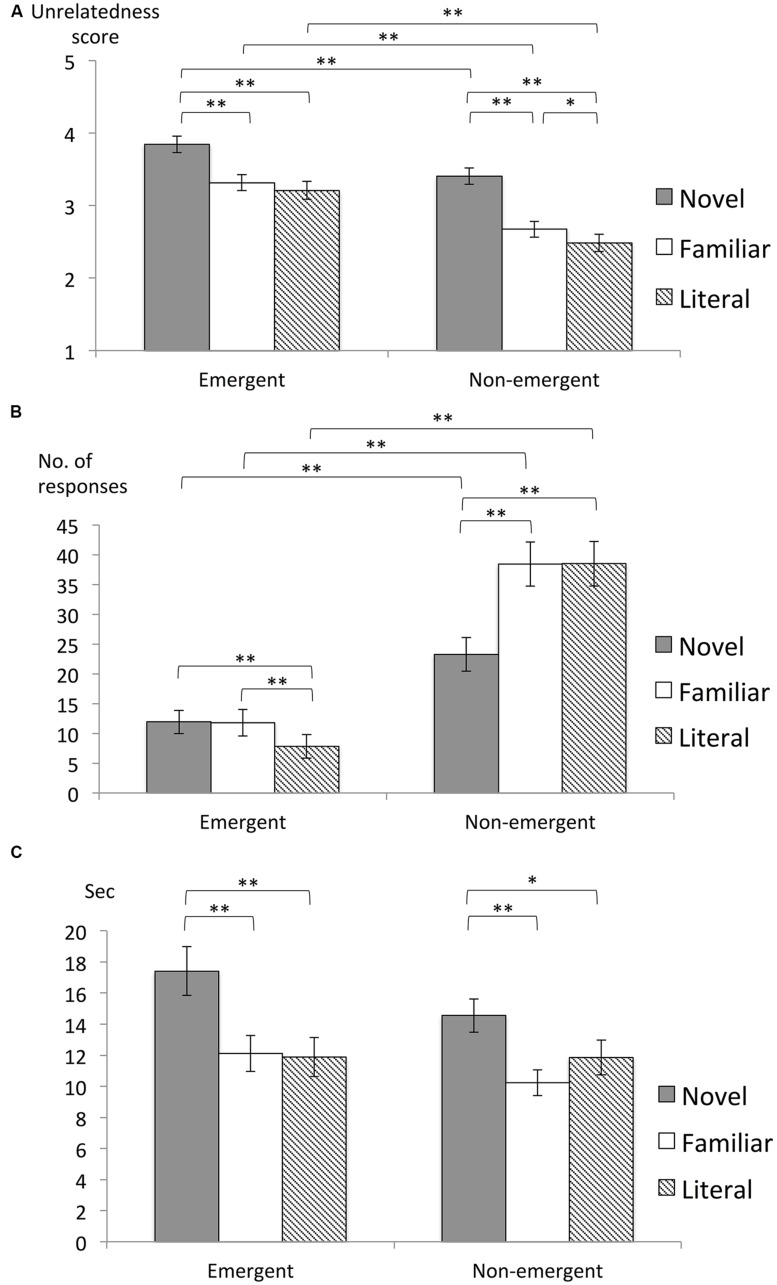
(A) Average ratings for the degree of semantic unrelatedness between generated responses and presented words (7: very unrelated; 1: very related) within the evaluations from the independent participant group (N = 102). (B) Average frequencies of responses in the free interpretation experiment. (C) Average durations to responses (DR) defined as the duration between the onsets of serial responses. Error bars represent the SEM across participants. ∗p < 0.05; ∗∗p < 0.01.